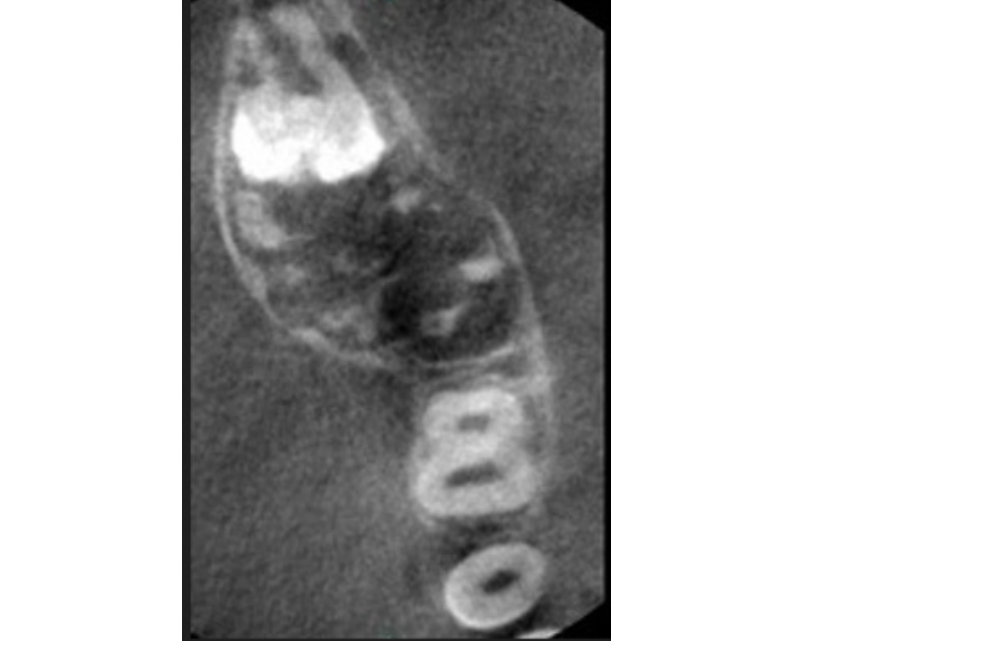
Figure 3. CBCT axial projection of the bone. The image shows an expansile, well ‐ circumscribed unilocular radiolucent lesion containing calcified masses compatible with odontogenic tissue and the unerupted right second molar (tooth 47). Courtesy of Dr. W. Pawlak.